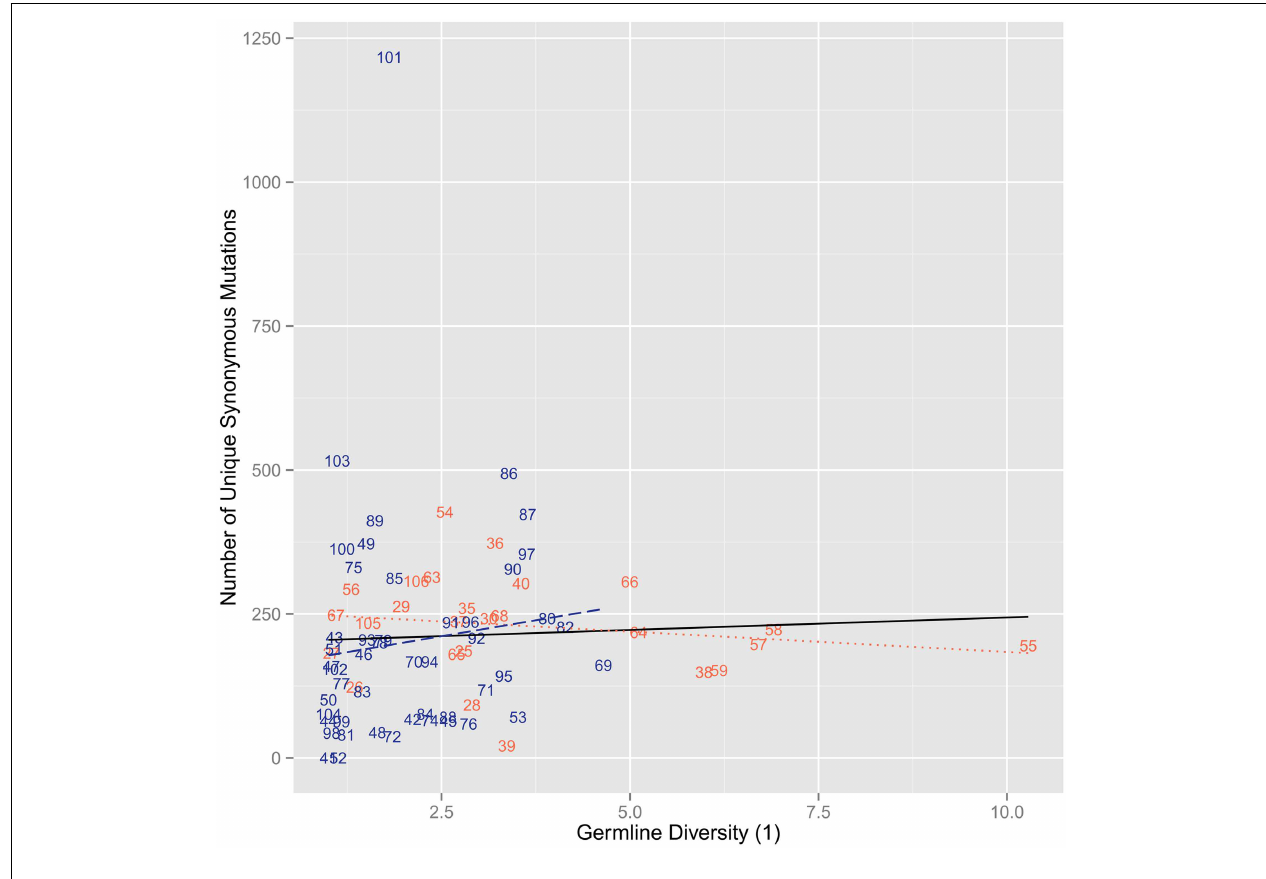
p = 0.0468).When splitting by region, we found no correlation for FR ( r 2 = 0.0127, ρ = 0.289, p = 0.0466) and CDR ( r 2 = 0.0322, ρ =− 0.223, p =